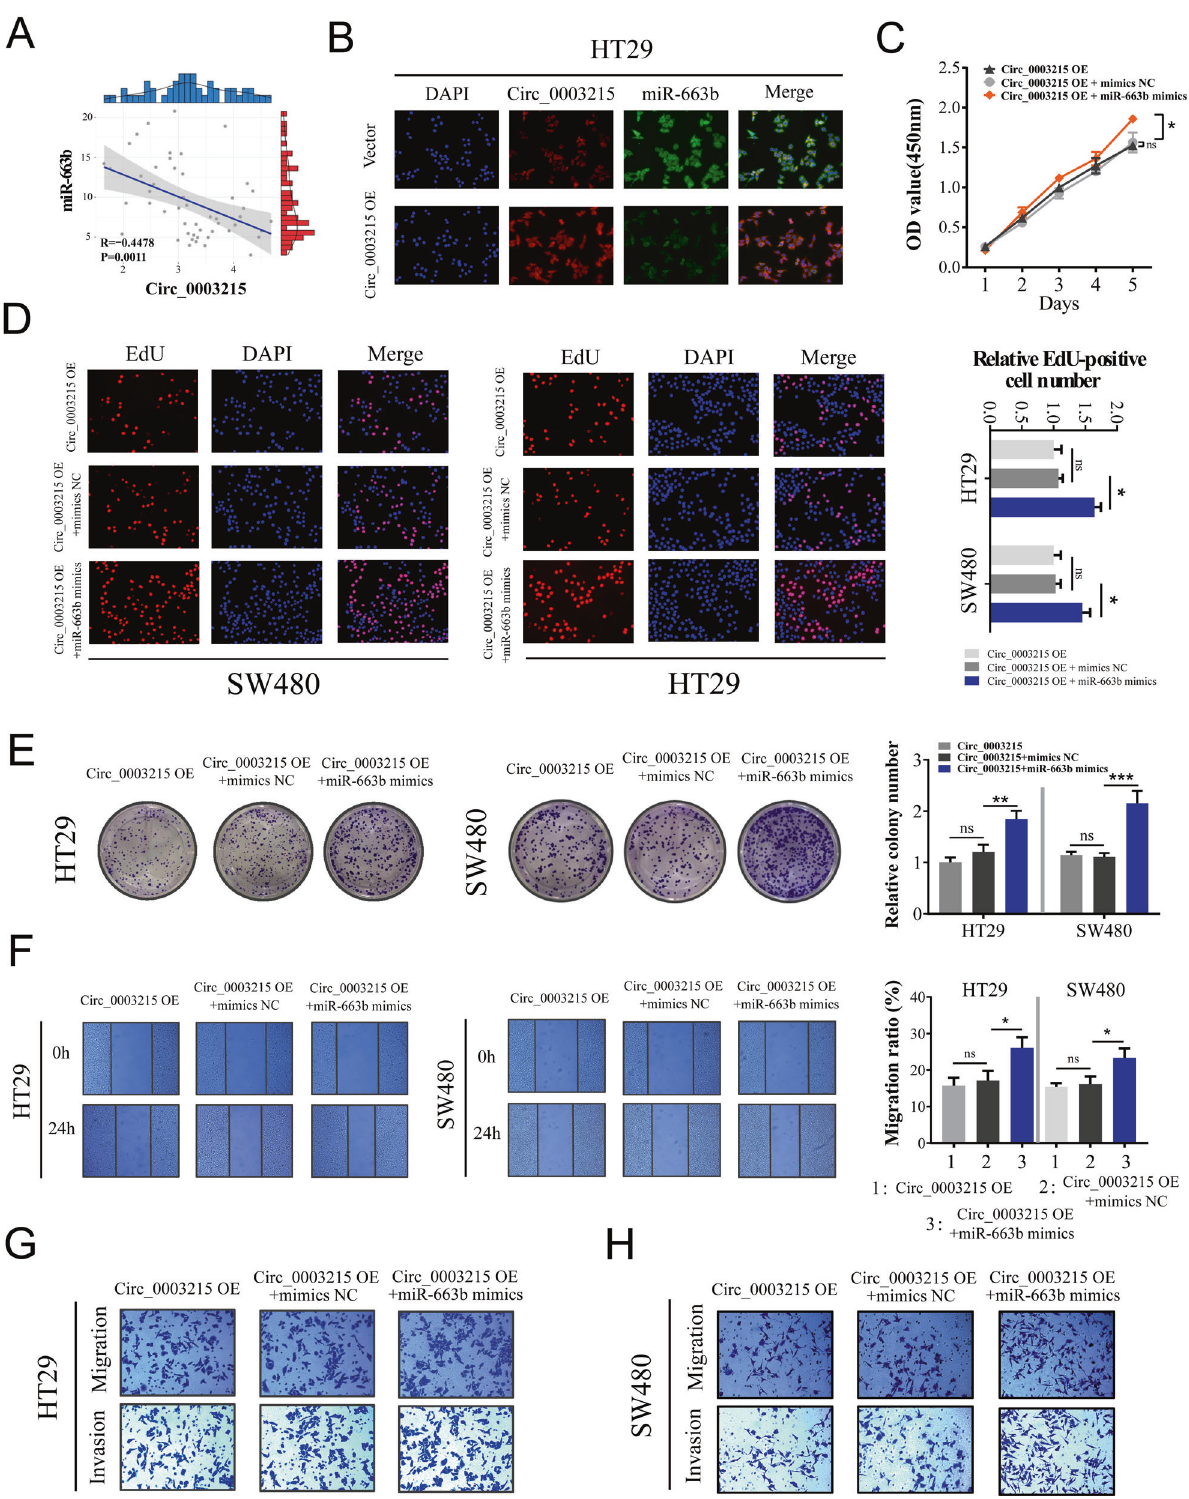
Fig. 5 MiR-663b can reverse the inhibitive effects of circ_0003215 in CRC cells. A Correlation analysis between the expression levels of circ_0003215 and miR-663b expression. B FISH analysis of circ_0003215(red) and miR-663b(green) in HT29 cells transfected with empty vector or circ_0003215 plasmid. C , D CCK8 and EdU analysis of the proliferation capacities in HT29 or SW480 cells with diferent transfection. E Colony formation assay of HT29 or SW480 cells transfected with diferent transfection F Wound healing assay to evaluate the cell migration of HT29 cells with diferent transfection. G , H Transwell assay for the invasion and migration ability of CRC cells transfected with indicated vectors. Graph represents mean ± SD; * P < 0.05, ** P < 0.01, *** P < 0.001.